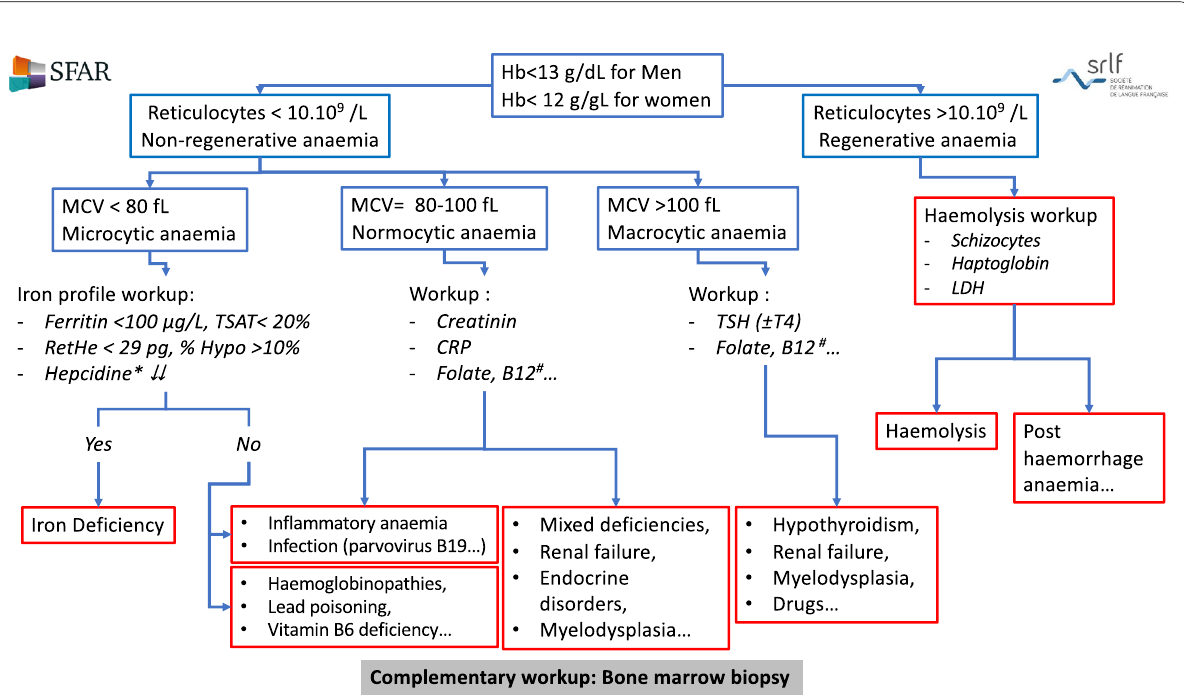
Fig. 1 Anemia diagnostic flow‑chart. This anemia diagnostic flow‑chart is presented as a guide. Asterisk: Hepcidin is not yet available in routine clinical practice. Hash: WHO defines folate deficiency as serum folate < 10 nmol/L (4.4 g/L) or red blood cell folate, reflecting long‑term status and tissue reserves, < 305 nmol/L (< 140 µg/L). Serum vitamin B12 < 150 pmol/L (< 203 ng/L) indicates vitamin B12 deficiency and a higher level does not exclude vitamin B12 deficiency, in which case blood methylmalonic acid must be assayed (a level > 271 nmol/L is in favour of vitamin B12